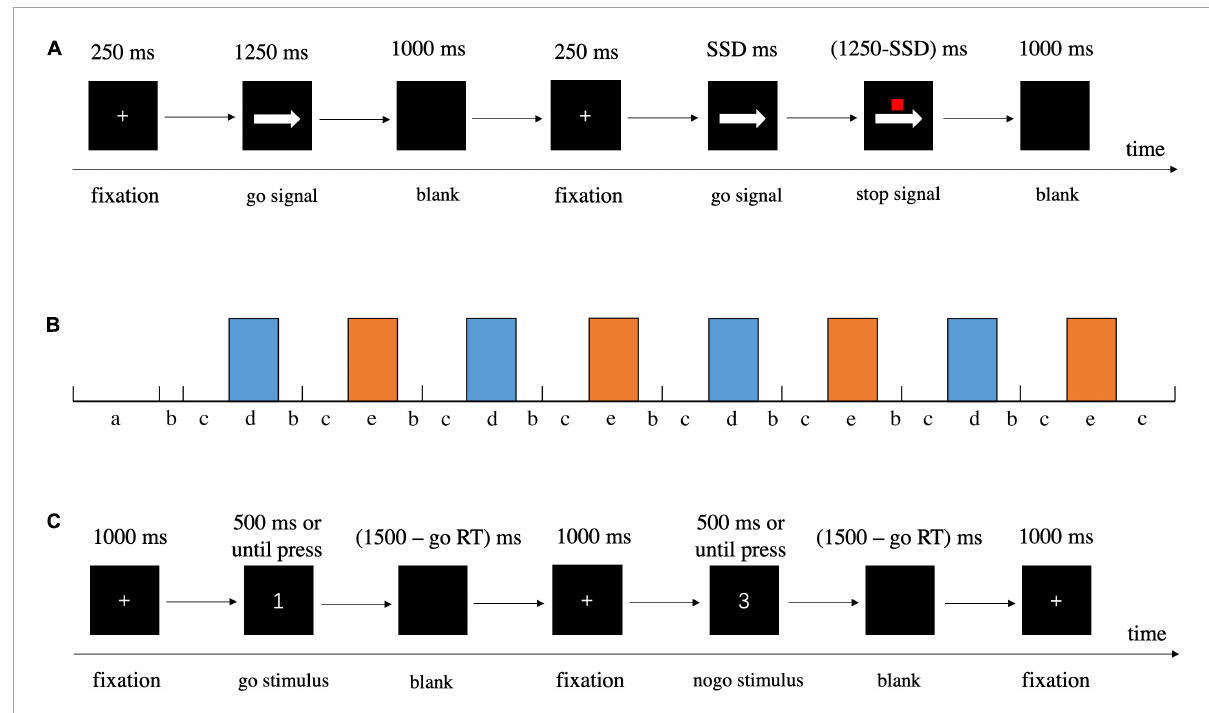
FIGURE3 Detailed information about procedures of behavioral tasks. (A) SST. (B) Schematic illustration of block design for GNG, a = instruction, b = cue, c = rest, d = go block, e = nogo block. (C) GNG.